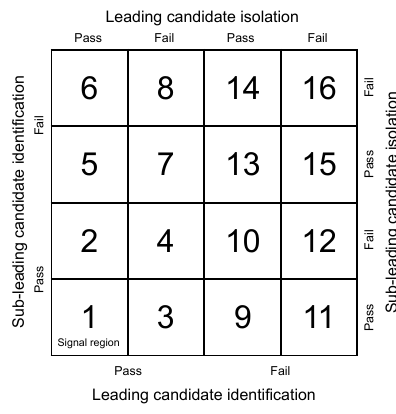
Figure 3. Definition of background control regions, and their corresponding label index.